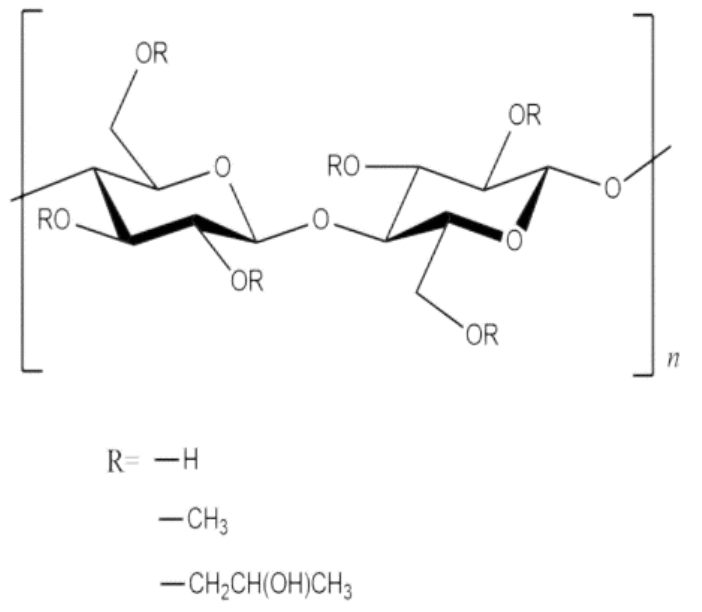
Figure 2. HPMC molecular structure diagram [33].